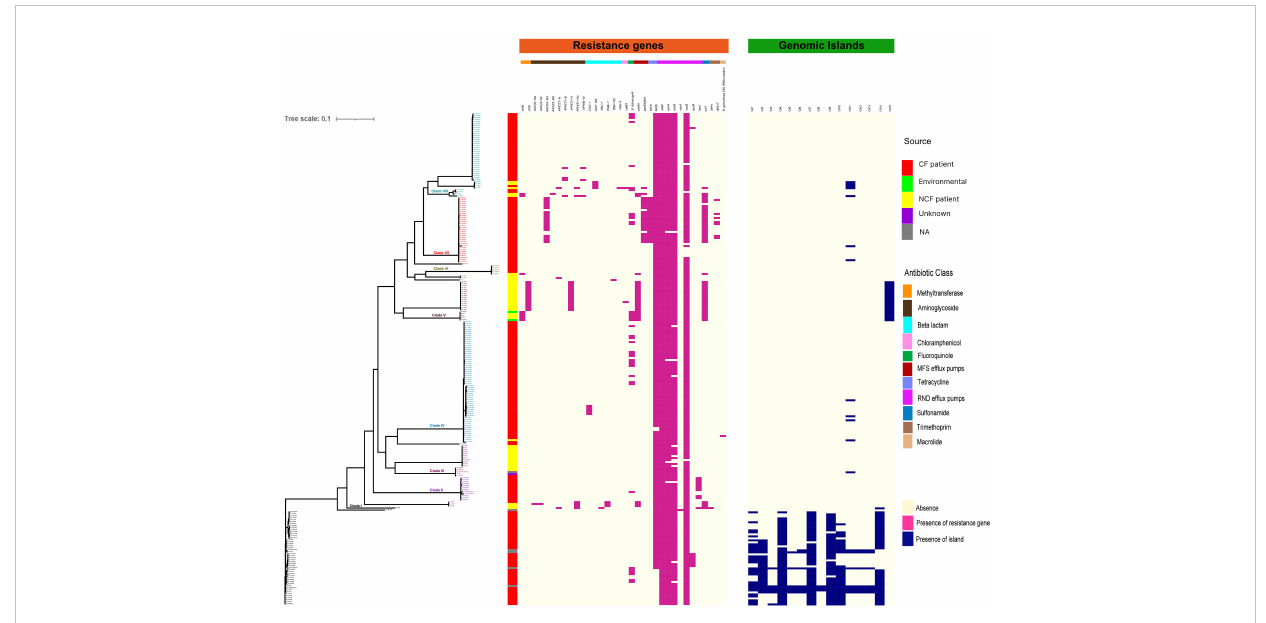
FIGURE 4 Distributions of mutations, resistance genes, and genomic islands in the CC31 lineage. Pink squares represent presence of resistance genes while blue squares represent the presence of